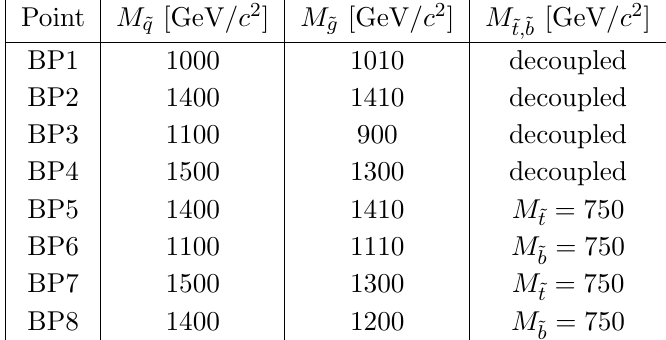
Table 1. Original BPs in